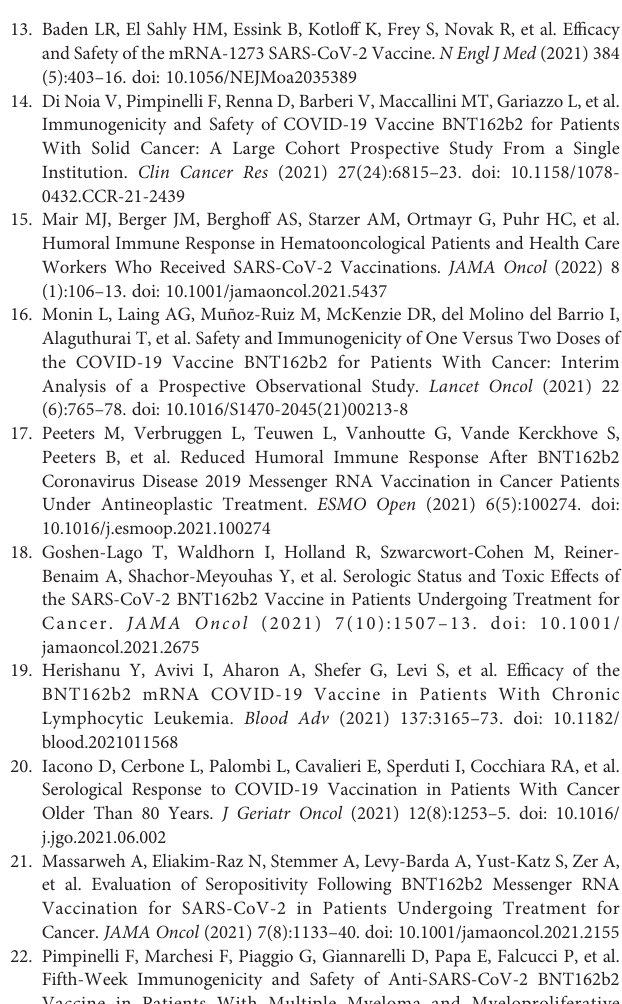
Supplementary Figure 1 | Percentages of responders from cohorts A, B.1, B.2 and C upon COVID-19 vaccination. The percentage of responders from Cohorts A (healthy donors), B.1 (CP under IMT, long lasting responders), B.2 (CP under IMT, adjuvant therapy) and C (CP not treated with IMT, no-IMT) in ELISA (A) , NeutraLISA (B) and ELISPOTs (C) after two doses of mRNA-based COVID-19 vaccines (3 w post boost time-point). Cohort A is represented by black bars, cohort B.1 by light blue bars, cohort B.2 by dark blue bars and cohort C by red bars. The ratio of responders to group size is given above each individual bar. Supplementary Figure 2 | SARS-CoV-2-speci fi c immune responses from cohort B subgroups B.1 and B.2 after COVID-19 vaccination. Spike-speci fi c IgG titers (A) , nAb titers (B) and Spike-speci fi c T cell responses (C) in CPs under immunotherapy (anti-PD1/PD-L1) from subgroup B.1 (long lasting responders) and subgroup B.2 (adjuvant therapy) after two doses of mRNA-based COVID-19 vaccines.Dotted linesindicatepositivethresholds forSpike-speci fi cIgG andTcells. In case of nAbs (C, D) , the dotted line determines the thresholds for negative, intermediate, and positive results according to manufacturer ’ s instructions. Bars represent